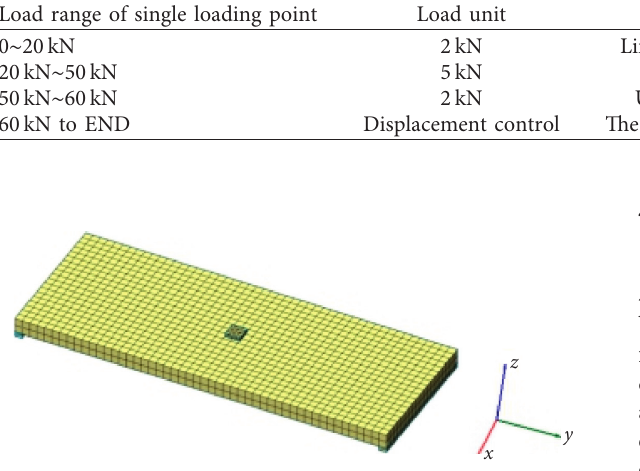
Figure 4: The established FEM.